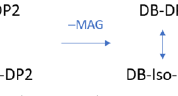
Fig. 10 Schematic comparison of the degradation pathways at 40 °C and 70 °C. Red arrows indicate the processes that are observed at 40 °C, and blue arrows indicate processes that are observed at 70